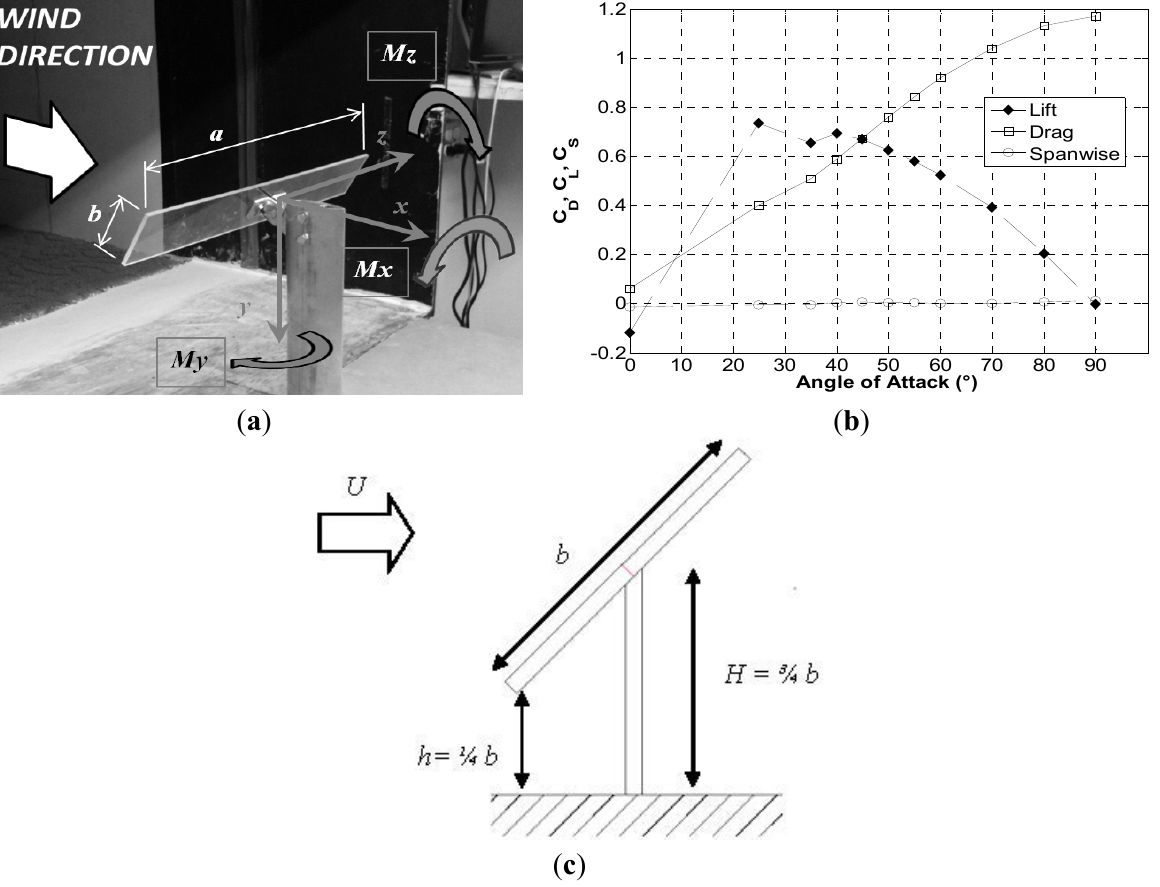
Figure 2. ( a ) Experimental stand showing a flat plate of AR = 3.58; ( b ) force coefficients as